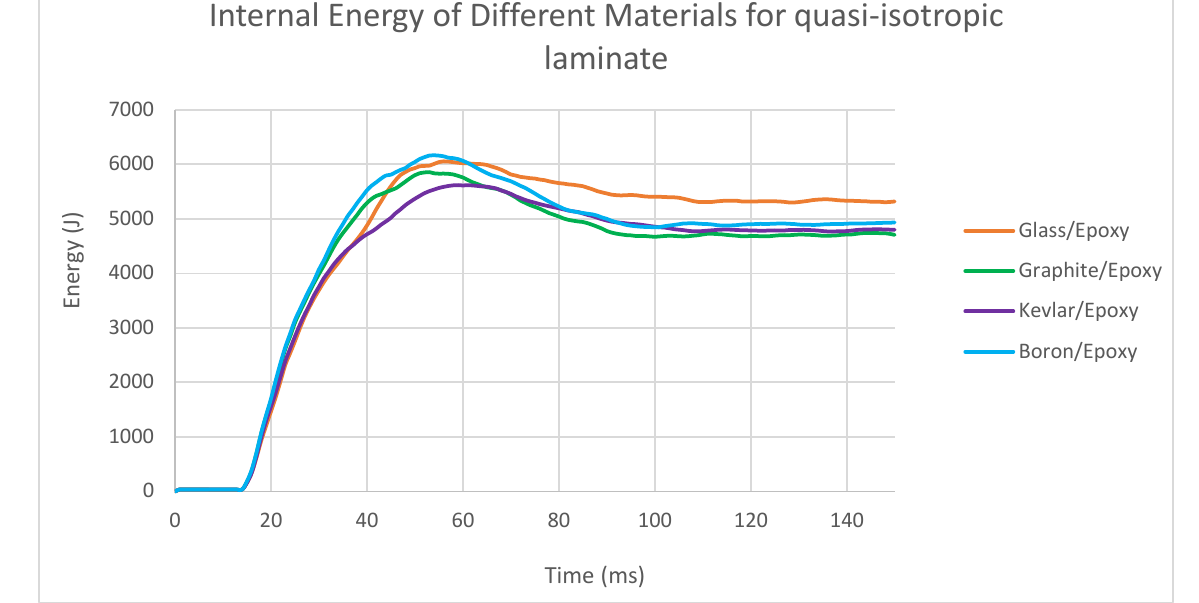
Figure 14: Total internal energy of fuselage made of different composite materials with quasi-isotropic laminate